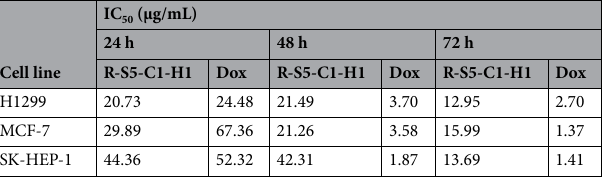
Table 1. IC 50 values for fraction R-S5-C1-H1 and doxorubicin in H1299, MCF-7, and SK-HEP-1 cell lines after 24 h, 48 h, and 72 h treatment.